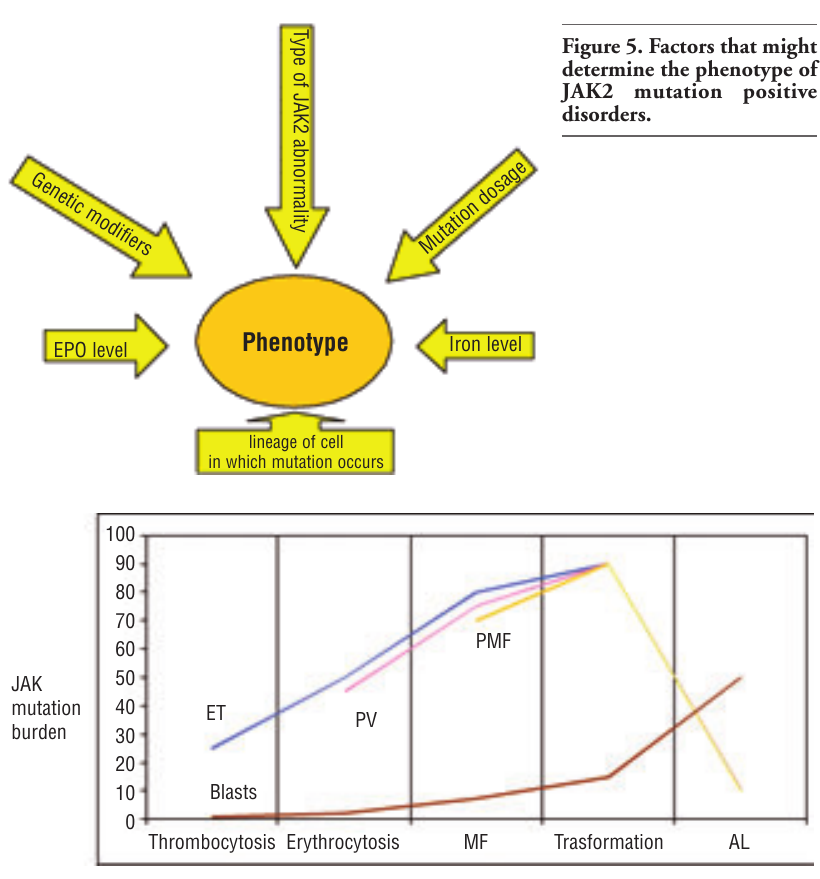
Figure 6. JAK2 mutation burden during progression of MPNs. AL: acute leukemia, ET: essential thrombocythemia, MF: myelofibrosis, PMF: primary myelofibrosis, PV: poly- cythemia